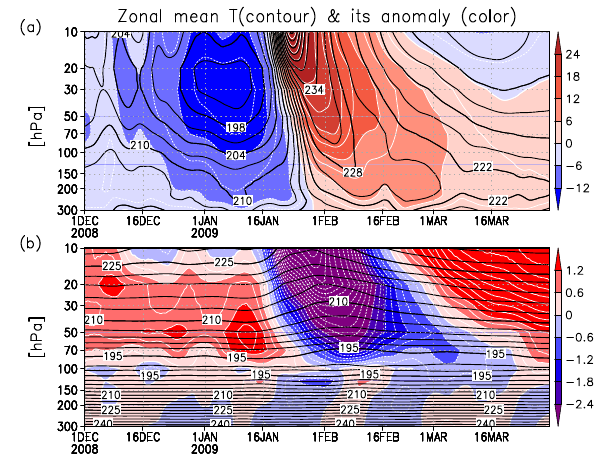
Fig. 1. Time-altitude section of zonal mean temperature (K; con- tours) and its anomaly (K; color shading) averaged over (a) 70 ◦ N– 90 ◦ N and (b) 10 ◦ S–10 ◦ N. The anomaly is the deviation from the 4-month (DJFM) mean. White contours show the anomaly of the zonal mean temperature, with contour intervals of 3K in (a) and 0.3K in (b) . Black contour interval is 3K. Data are smoothed using a 5-day running